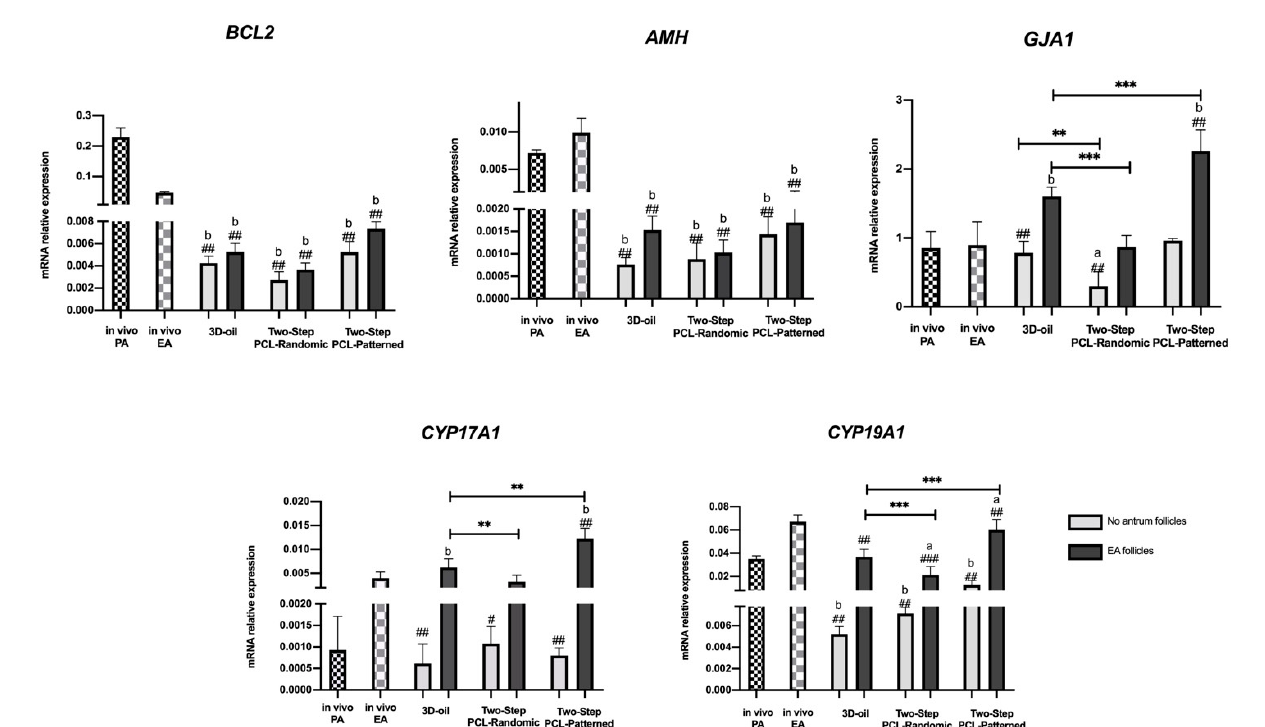
Figure 7. Representative expression of steroidogenic and somatic-specific genes. Twelve follicular walls per group were processed for gene expression analysis. Data were expressed as mean ± SD.